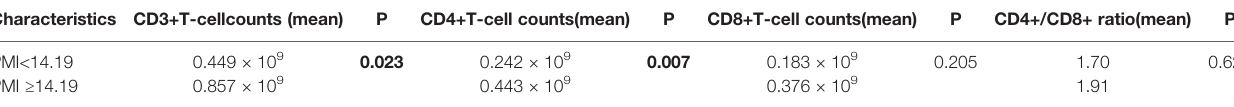
TABLE 5 | Peripheral blood T-cell subsets according to PMI. Characteristics CD3+T-cellcounts (mean) P CD4+T-cell counts(mean) P CD8+T-cell counts(mean) P CD4+/CD8+ ratio(mean) P